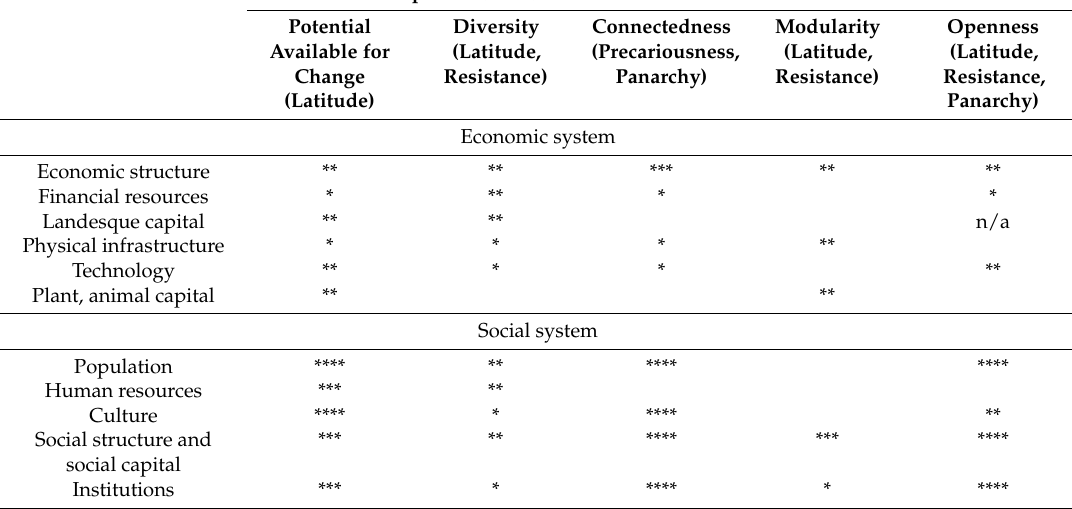
Table 7. Adaptability Assessment Matrix (AAM) of the “Cereal modernization phase, 1950–1970”. Lower Level Properties (LLPs) and Associated Characteristics of the Basin of Attraction Potential Diversity Available for Change (Latitude)